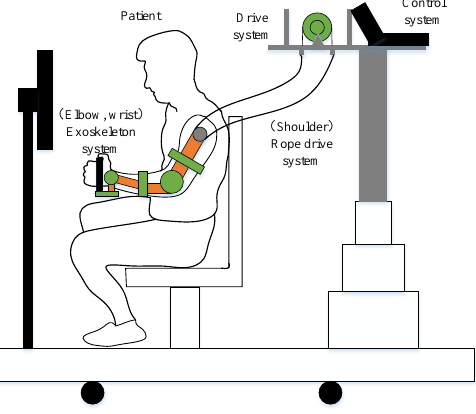
Figure 1. Overall design of the structure of the rope-driven exoskeleton multiplexing robot.